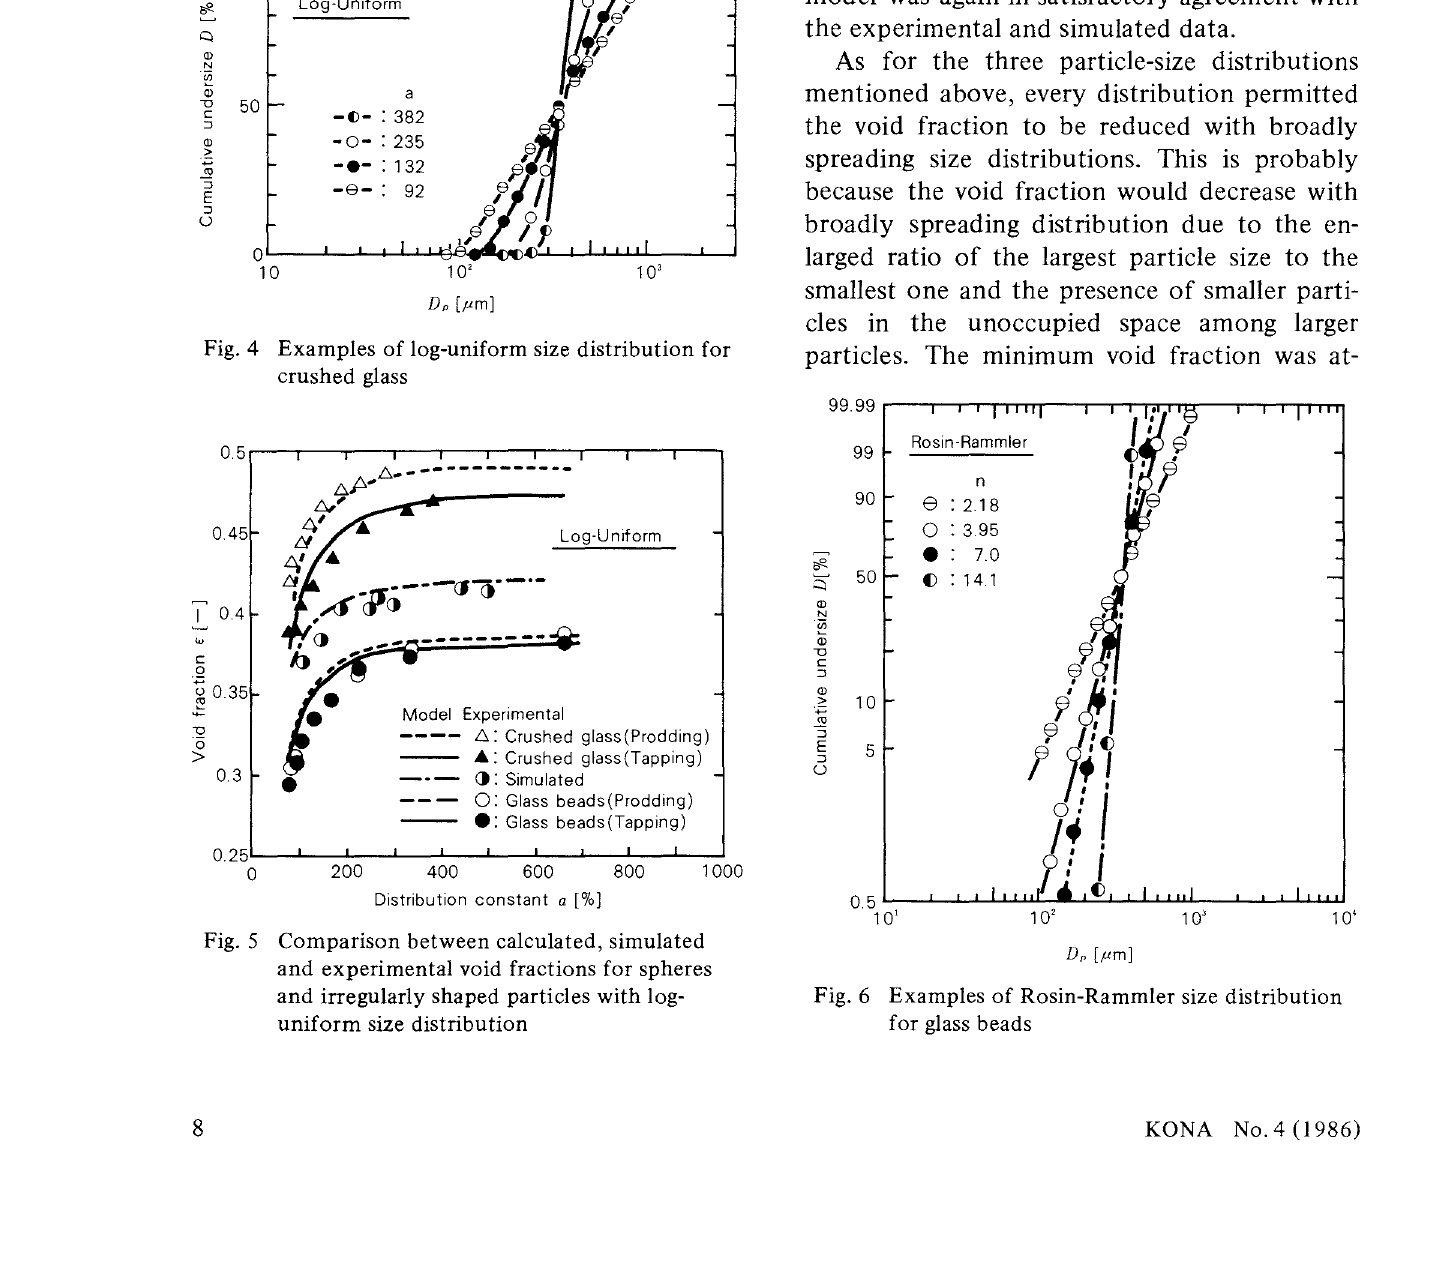
Fig. 6 Examples of Rosin-Rammler size distribution for glass